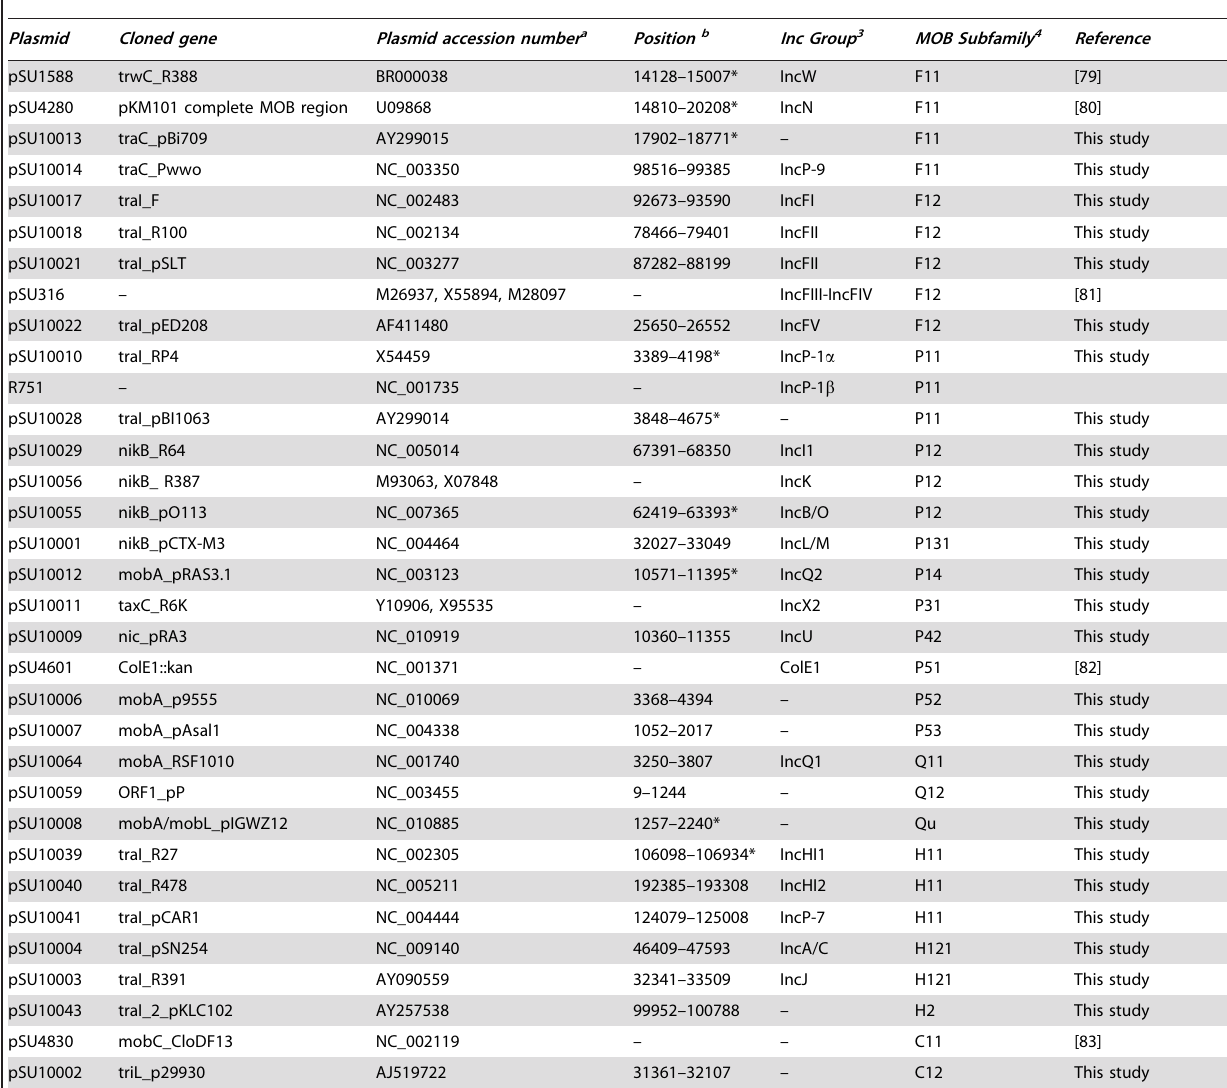
Table 1. Plasmids and relaxase genes used as controls in validation